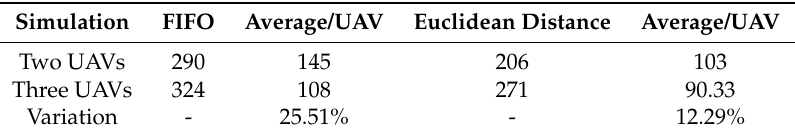
Figure 11. Displacement—Scenario 1. Table 3. Displacement number—-Scenario